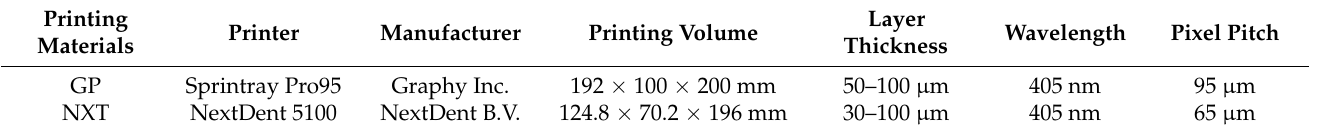
Table 2. Characteristics of 3D printing